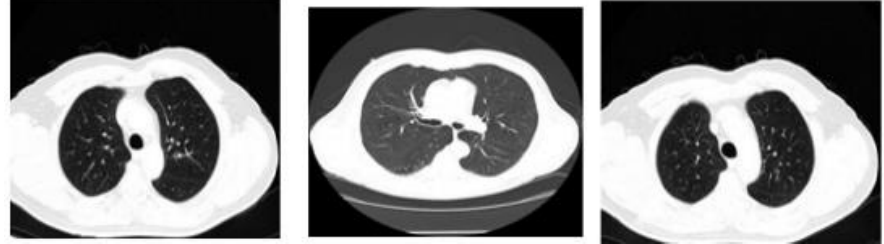
Figure 2. Framework for the detection of Lung cancer for a CAD System [28].